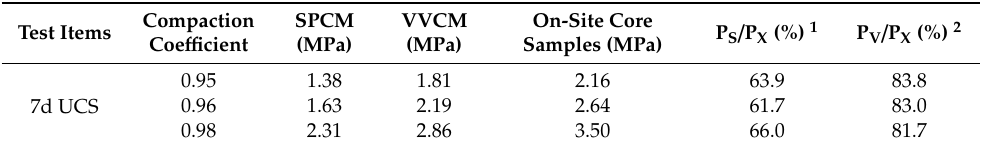
Table 3. Seven-day (7d) unconfined compressive strength (UCS) test results for specimens formed by the vertical vibration compaction method (VVCM), specimens formed by the static pressure compaction method (SPCM), and field core